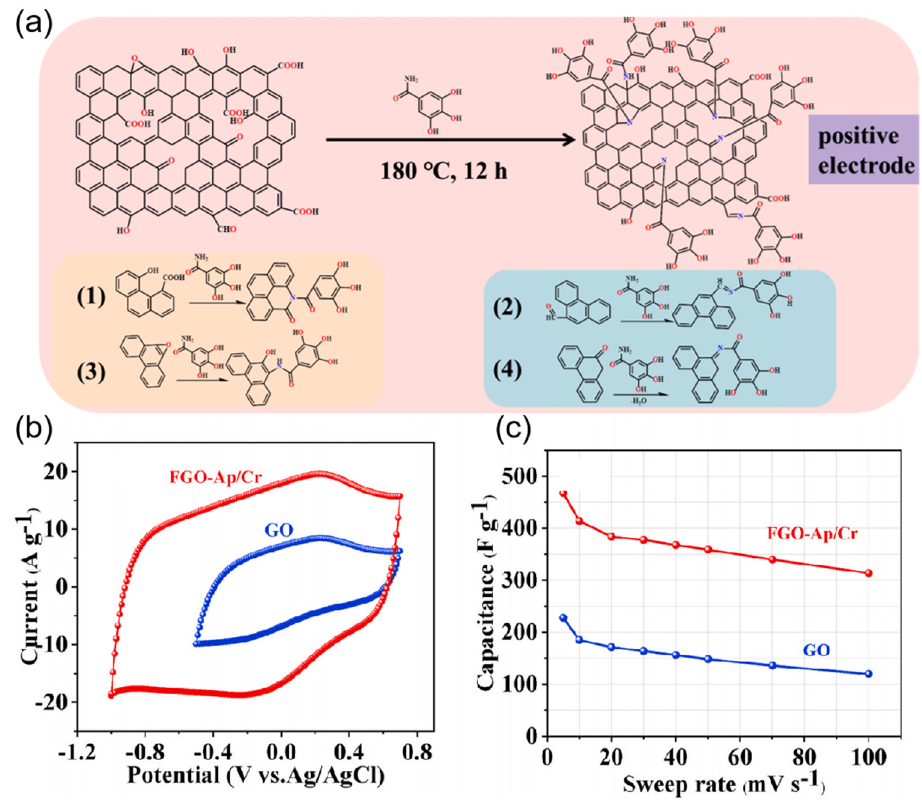
Figure 9. ( a ) Illustration of the sample preparation process and likely reaction mechanism for RGO- THBA. Reprinted with permission from [80]. Copyright (2021) American Chemical Society. ( b ) Cyclic voltammograms of the FGO-Ap/Cr and GO at 50 mV s − 1 . ( c ) Special capacitance on the basis of the sweep rates for the FGO-Ap/Cr and GO. Reprinted from [83]. Copyright (2021), with permission from Elsevier.